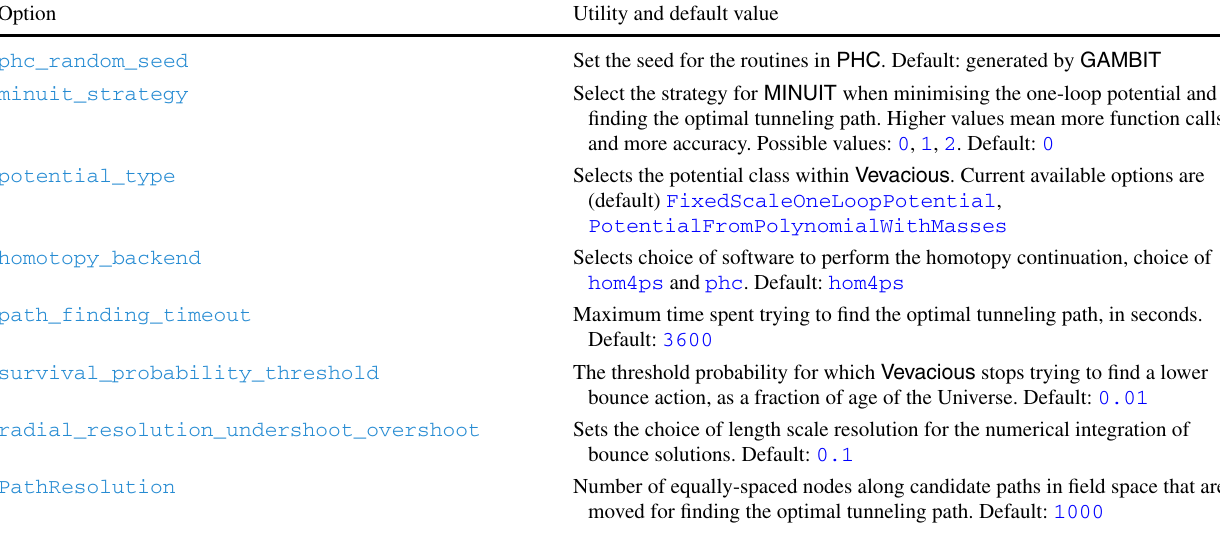
Table 3 Table of the runOptions available to the module function initialize_vevacious , which is used to pass runtime options to